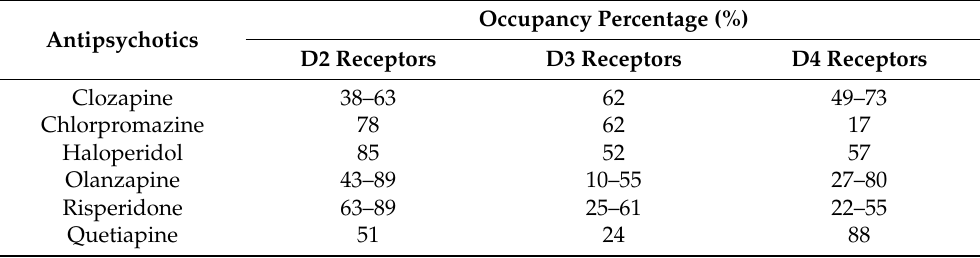
Table 2. Dopamine receptors occupancy while taking antipsychotics (Adapted from [27], Copyright year 2013 Neurosci.